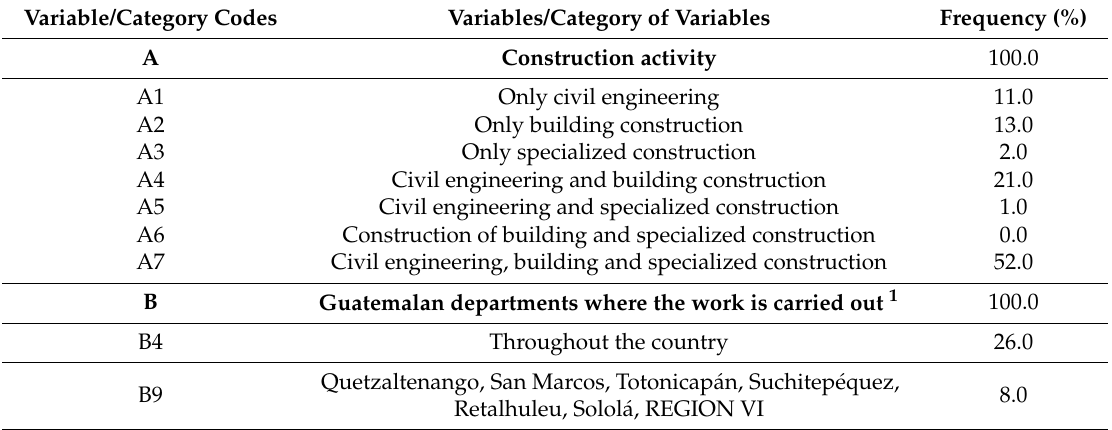
Table A1. Nomenclature and frequency of the categories of general company